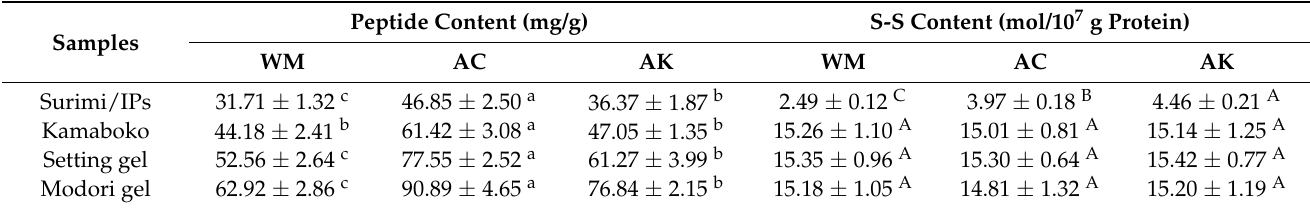
Table 2. TCA-soluble peptide content (mg/g) and disulfide content (mol/10 7 g protein) of WM, IPs and gels prepared under different conditions.